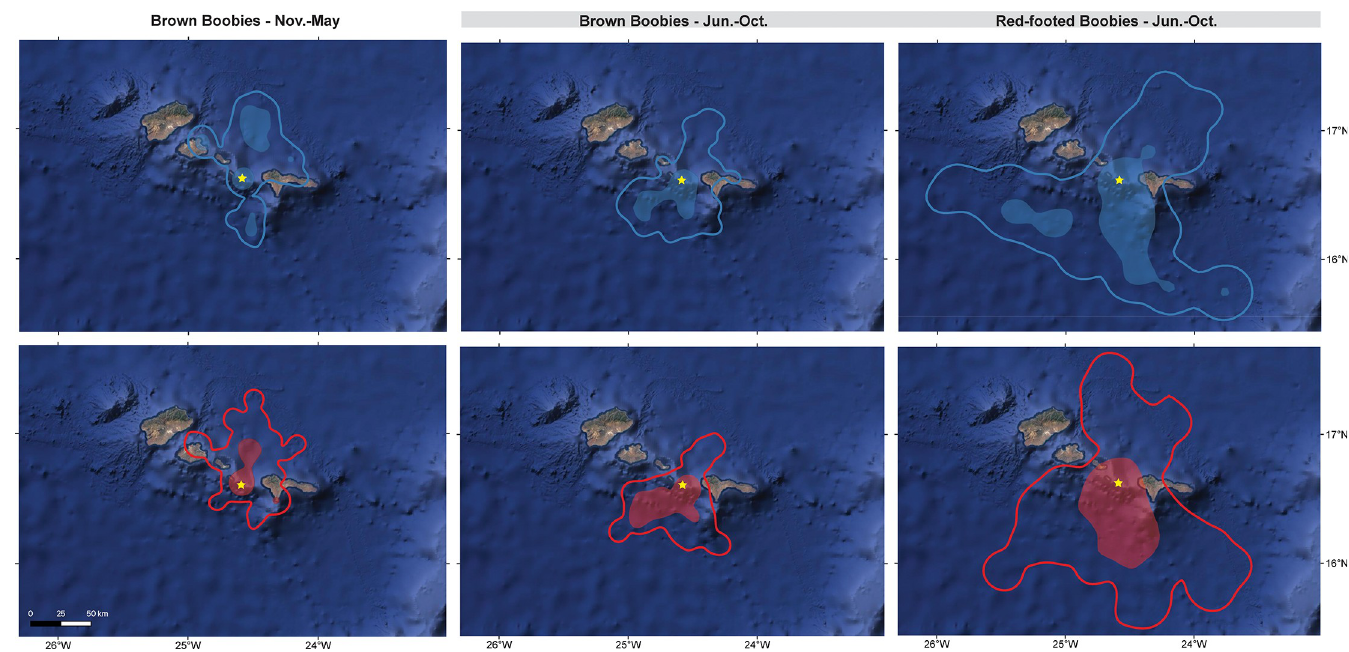
Fig 1. Kernel Utilization Distributions (UDs) of female (blue) and male (red) brown (BRBO) and red-footed (RFBO) boobies, tracked between November 2018 – October 2019 at Raso Islet (star), Cabo Verde. Bathymetric relief in the background (max. 4012m). Shaded area highlights the period when BRBO and RFBO co-occur in